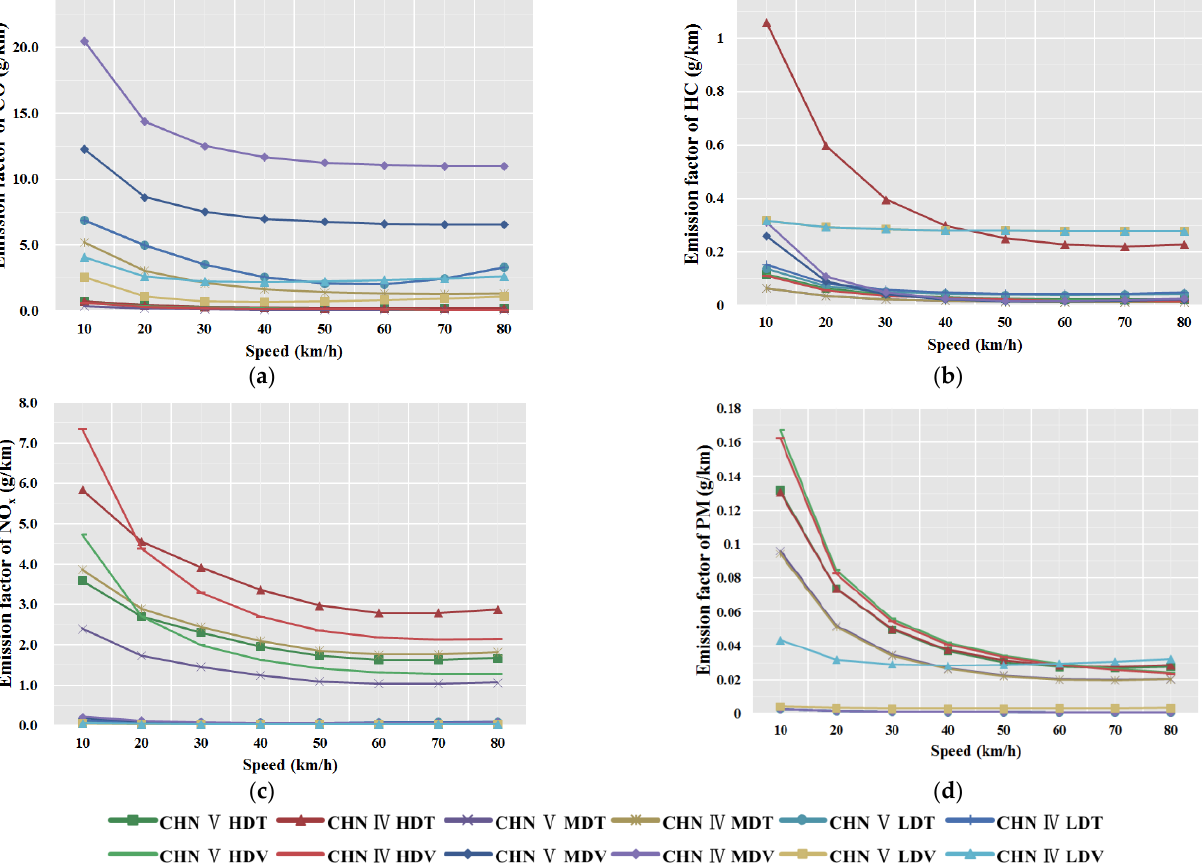
Figure 13. The emission factors of different tested vehicles; ( a ) Emission factors of CO; ( b ) Emission factors of HC; ( c ) Emission factors of NOx; ( d ) Emission factors of PM.